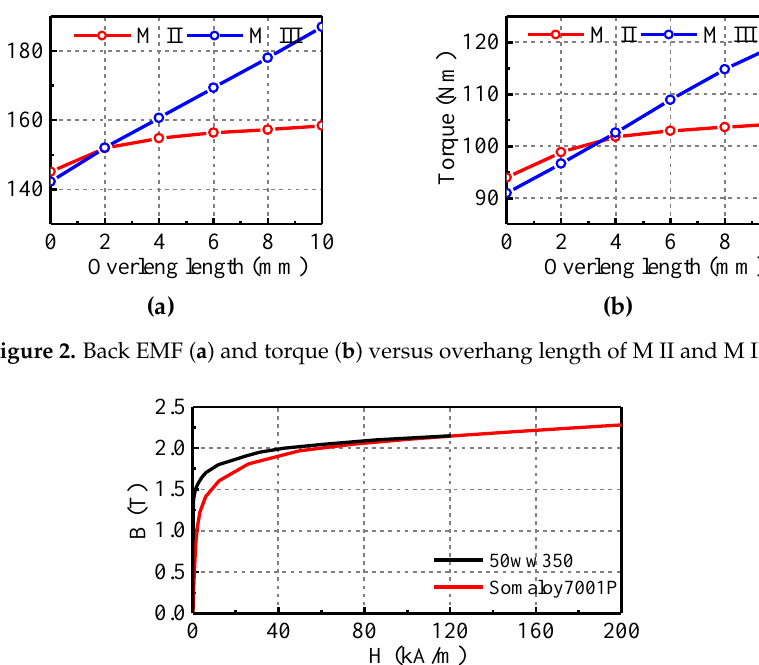
Figure 3. B – H curve of silicon steel and SMC.